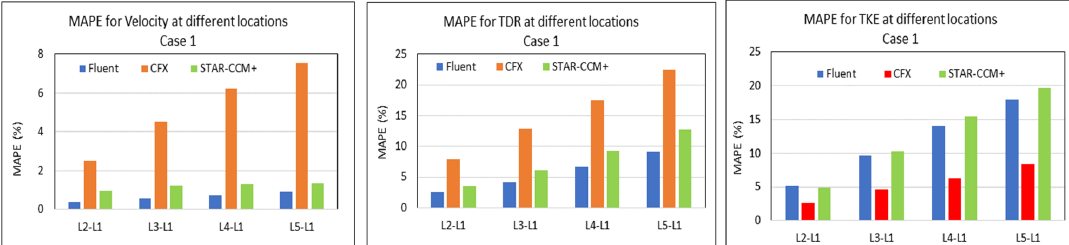
Figure 7. Case 1: Comparison of the Mean vertical variations of the Absolute Percentage Figure7. Case1: Comparisonofthe Mean verticalvariationsoftheAbsolutePercentageError / di ff erences Error/differences (MAPEs) (based on the results of Figure 6) for each of the parameters (u, TKE (MAPEs) (based on the results of Figure 6) for each of the parameters (u, TKE (turbulent kinetic energy), and TDR (turbulent dissipation rate) with each software: (i) Fluent and (ii) Star-CCM + implement the realizable k– ε model, whilst (iii) CFX implements the standard k– ε model.